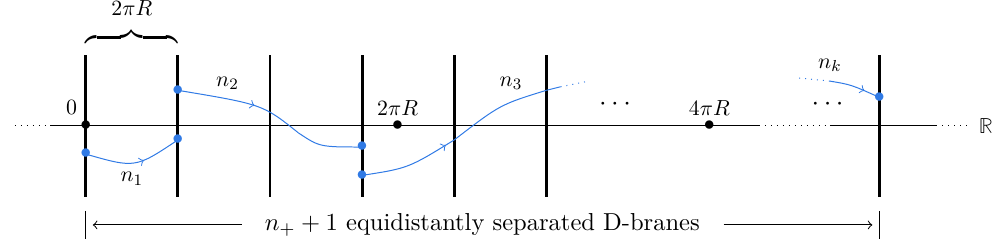
Figure 2. The horizontal line represents the real axis, which under the x ∼ x + 2 πR identification becomes a circle of radius R . The vertical lines represent an array of equidistantly separated D- branes. The distance between consecutive D-branes is 2 π e R , where e R = α 0 /R is the T-dual radius. Each blue curve represents an incoming open string stretched between different D-branes. The momentum n i of the i -th closed string is encoded in the number of D-branes traversed by the i -th open string and physically corresponds to fractional winding.